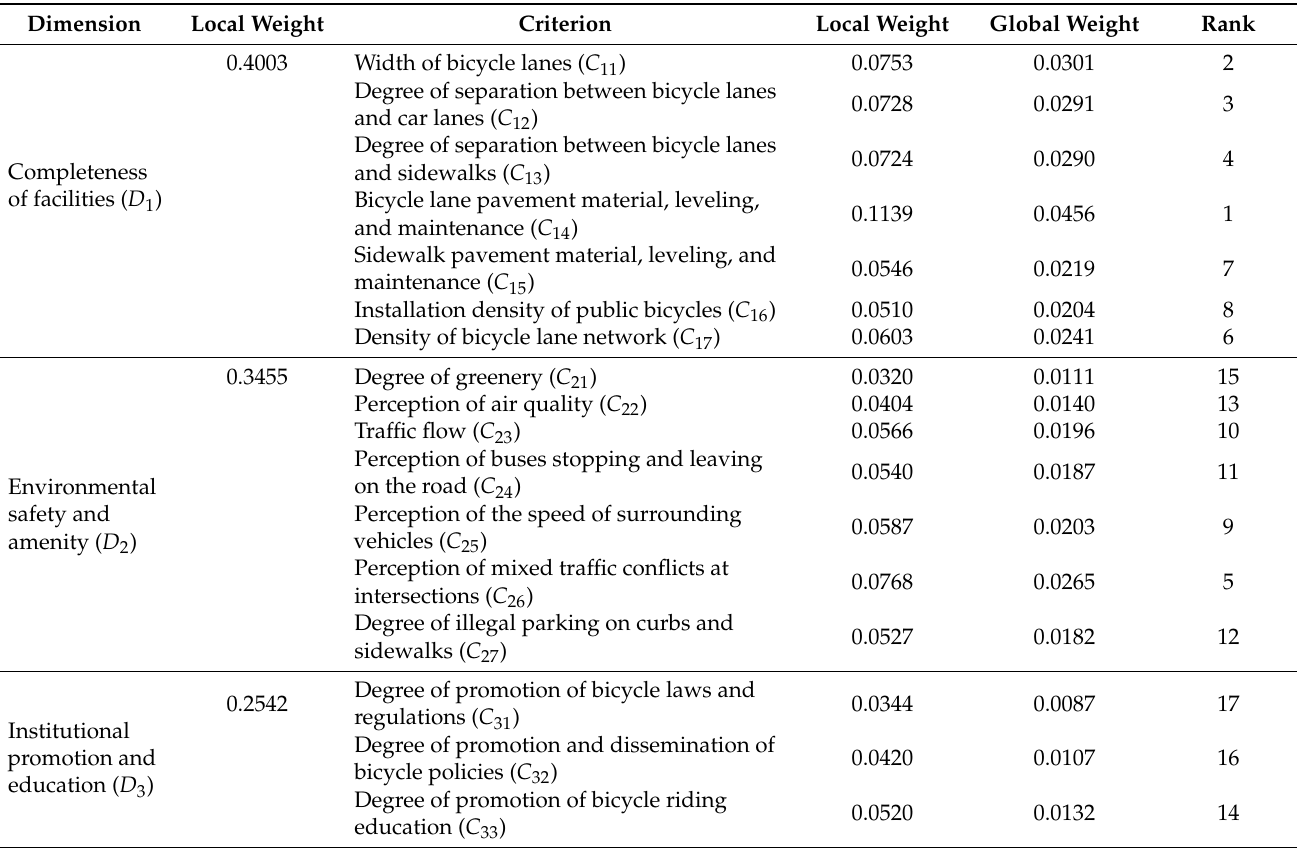
Table 6. Weighted results from the Bayesian BWM